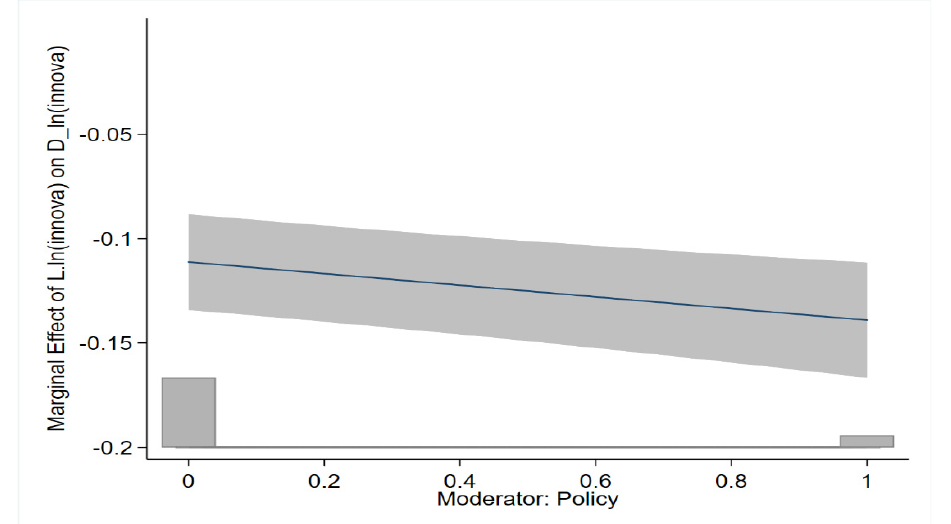
Figure 3. The moderating effect of the pilot policy on innovation convergence.